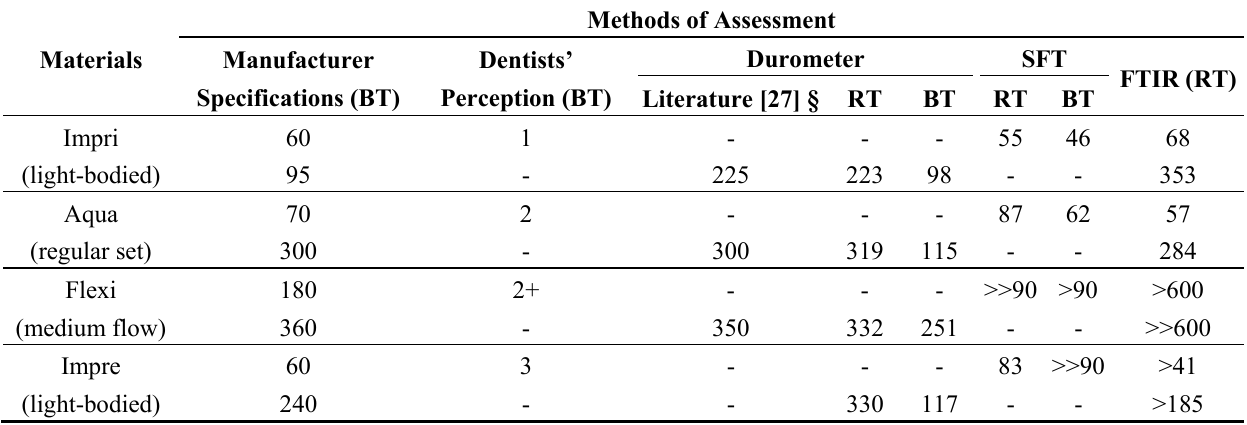
Table 1. For each cell, the top row value is t w and the bottom row one is t s , where available. All numerical values are means ( N ≥ 4) in seconds. The column of dentist’s perception is a qualitative score, higher score means best, + shows only a slight